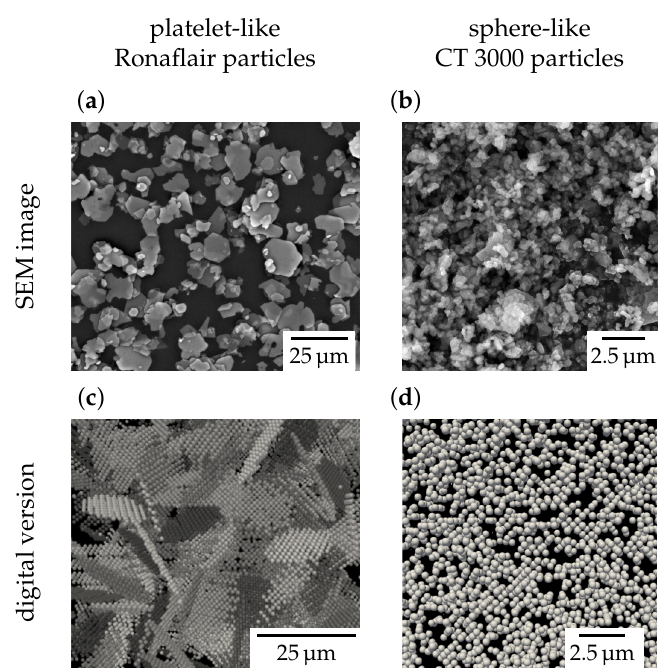
Figure 4. The Ronaflair ( a ) and CT3000 particle systems ( b ) as observed by SEM images and as represented in the numerical simulation ( c , d ).